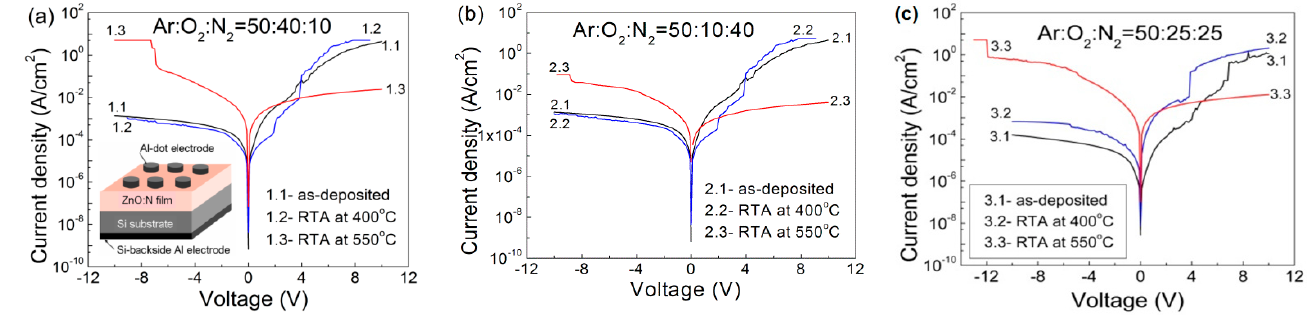
Figure 3. Automatically recorded I–V characteristics of MIS structures with ZnO:N films, deposited at different gas ratios: Ar:O 2 :N 2 = 50:40:10 ( a ), Ar:O 2 :N 2 = 50:10:40 ( b ), and Ar:O 2 :N 2 = 50:25:25 ( c ). The corresponding sample numbers are given in the insets. The lower left inset in ( a ) shows the schematic structure of the measured samples.